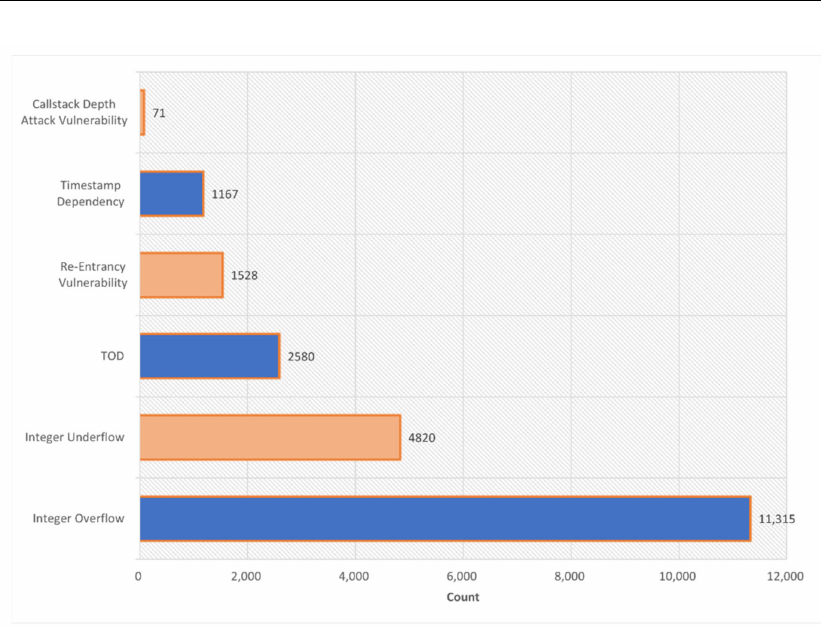
Figure 4. Distribution of each type of vulnerability as a percentage of the overall